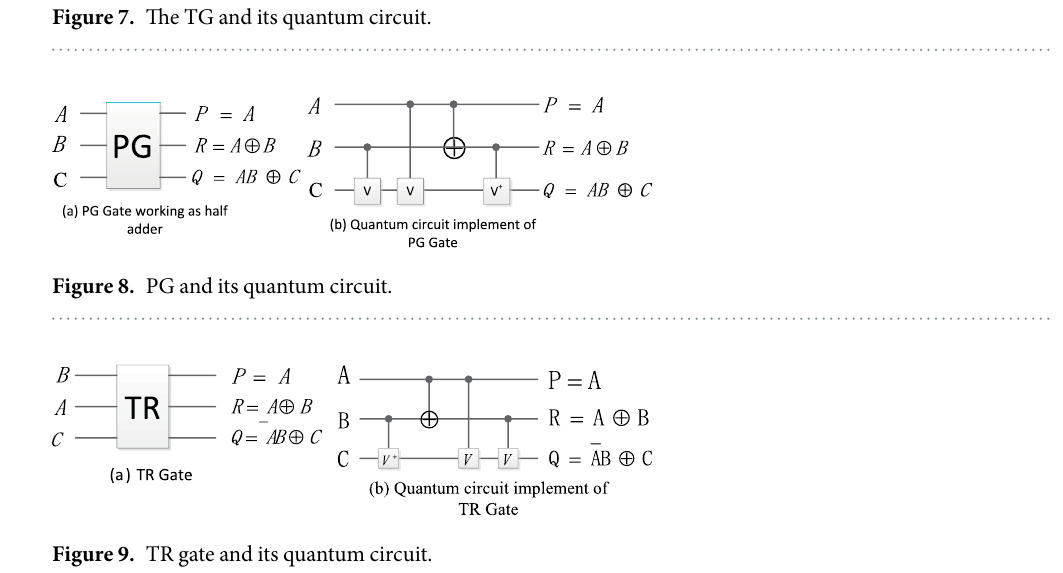
Figure 7. The TG and its quantum circuit.